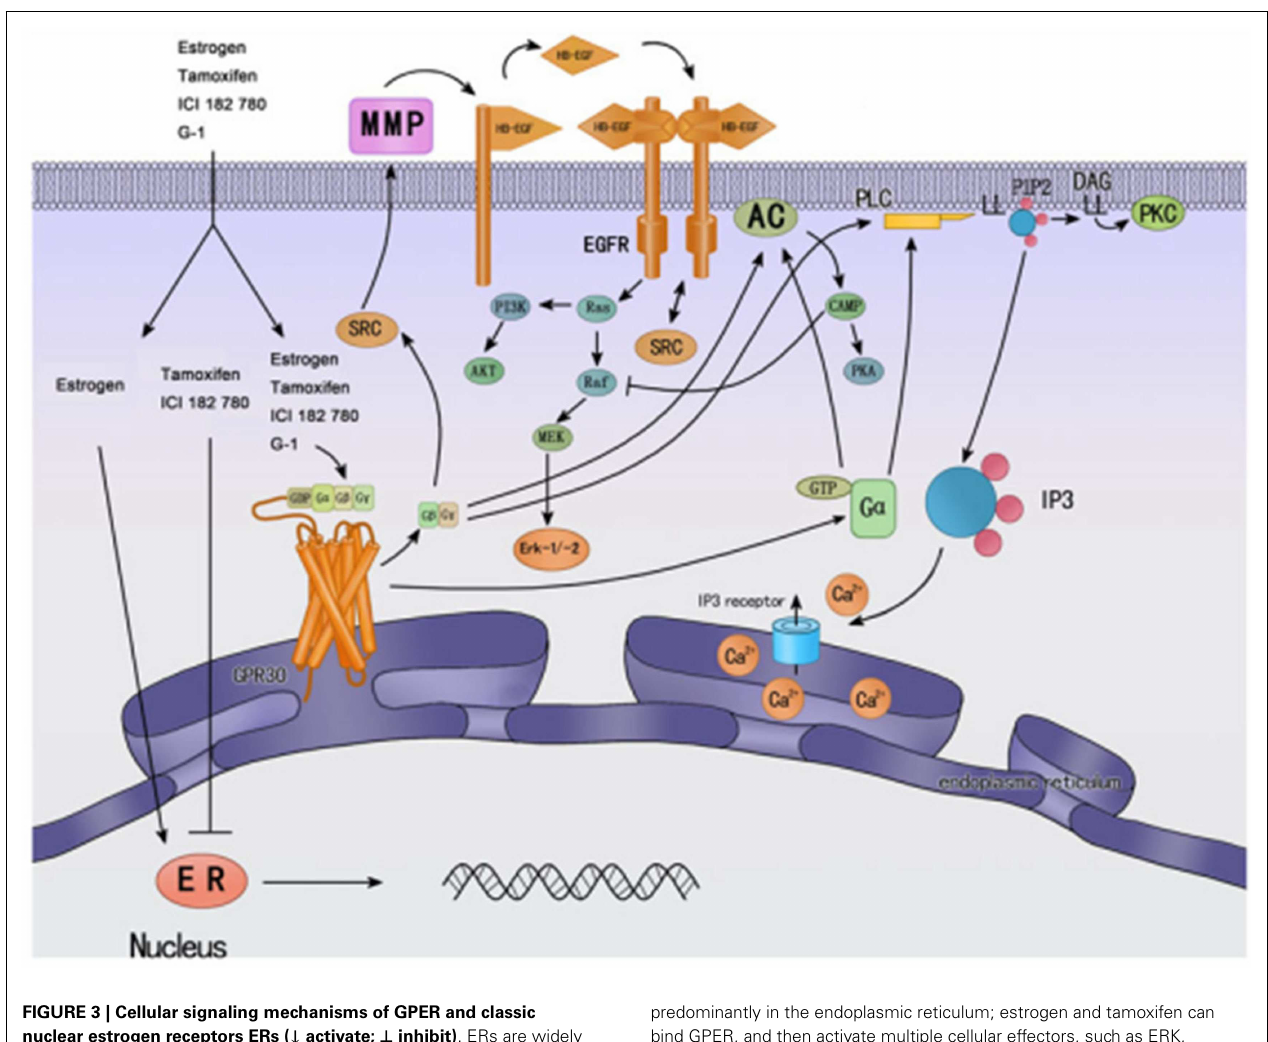
FIGURE 3 | Cellular signaling mechanisms of GPER and classic nuclear estrogen receptors ERs ( ↓ activate; ⊥ inhibit) . ERs are widely accepted as mainly mediating gene transcriptional regulation.Tamoxifen is an ER antagonist in some tissue, such as breast cancer, while has agonistic effects in other tissues, such as endometrium. GPER was found